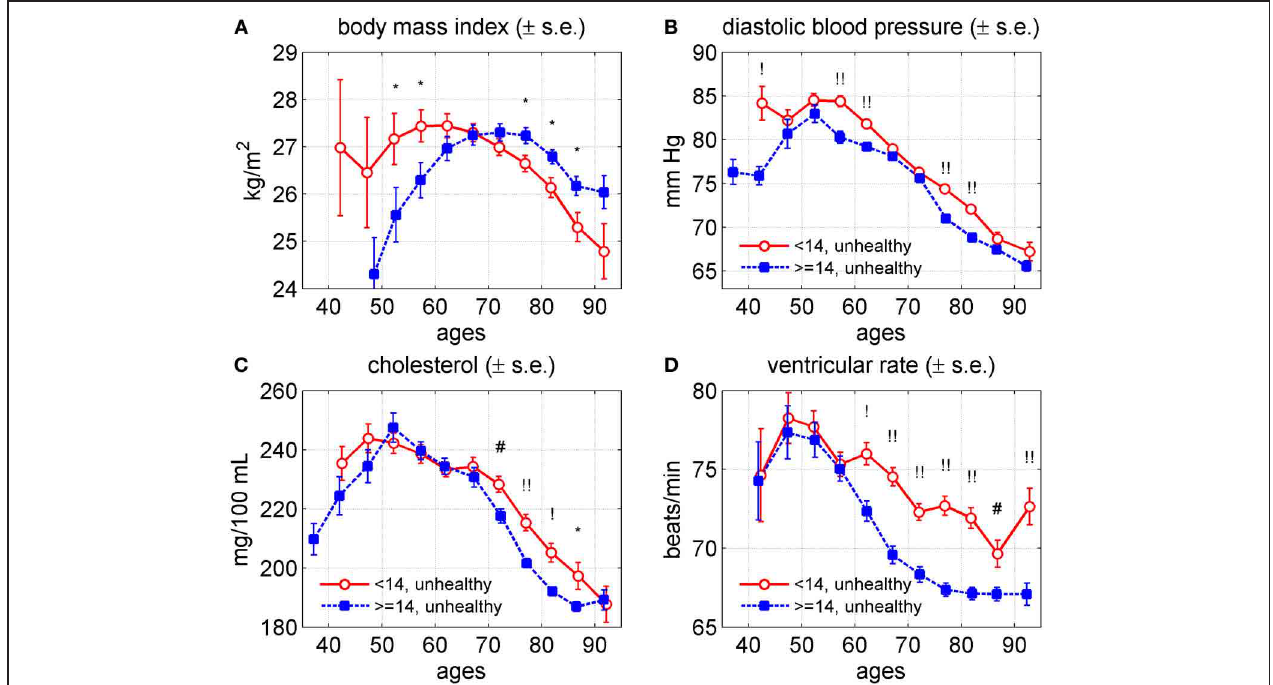
“healthy” are those free of these three diseases. Measurements of physiological indices before the onset of any of these diseases contribute to the “healthy” trajectory and those after the onset of any of the diseases contribute to the “unhealthy” trajectory. Symbols above the curves correspond to p -values for testing the null hypotheses on equality of means in respective age groups: no symbol: p ≥ 0 . 05;